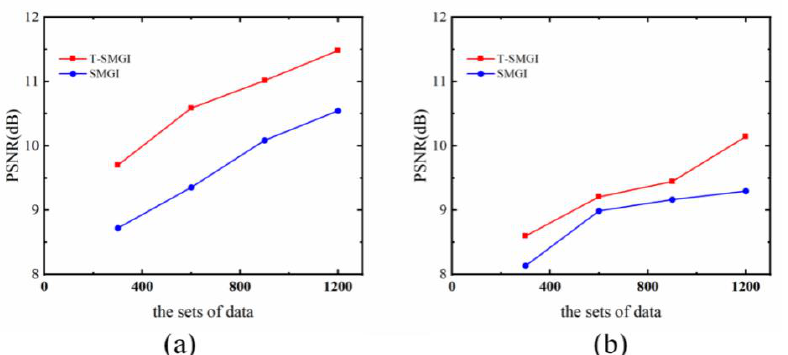
Figure 8. PSNR curves of the reconstruction result “GI” and “ZHONG” of SMGI and T-SMGI; ( a ) the PSNR curves of the “GI” of SMGI and T-SMGI; ( b ) the PSNR curves of SMGI and T-SMGI of “ZHONG”.